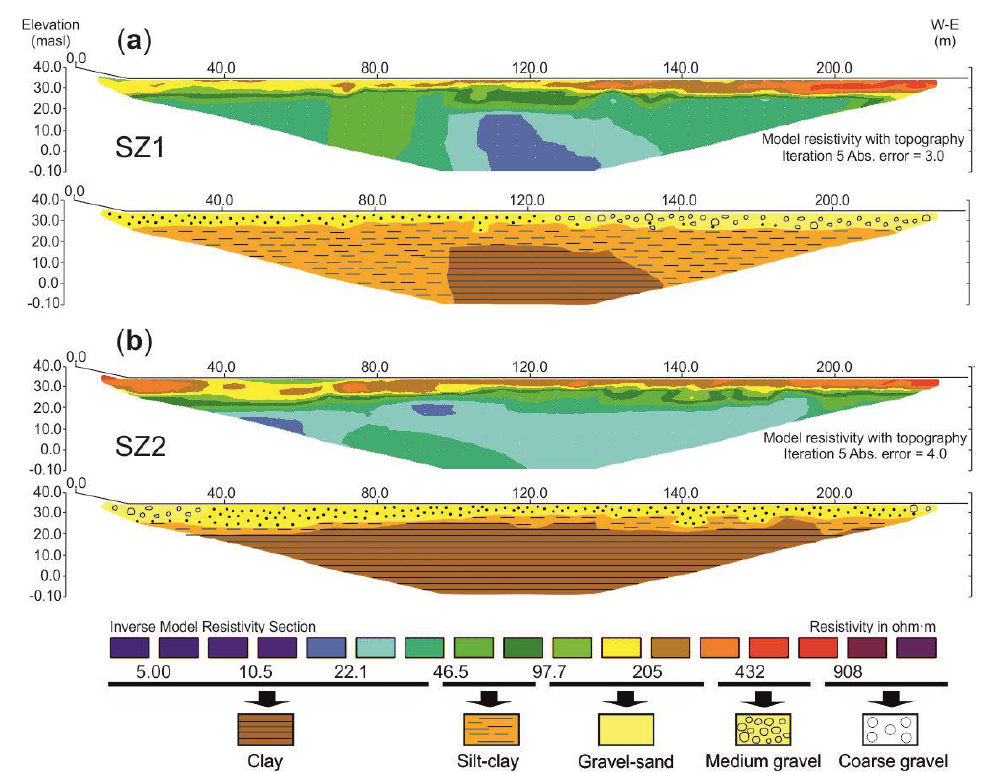
Figure 3. ( a ) SZ1 inverted resistivity cross-section and its lithological interpretation, ( b ) SZ2 inverted resistivity cross-section and its lithological interpretation. Both cross-sections show the variability of the upper layer and the limit between the high aquifer (high resistivity values) and the impervious substrate (low resistivity).